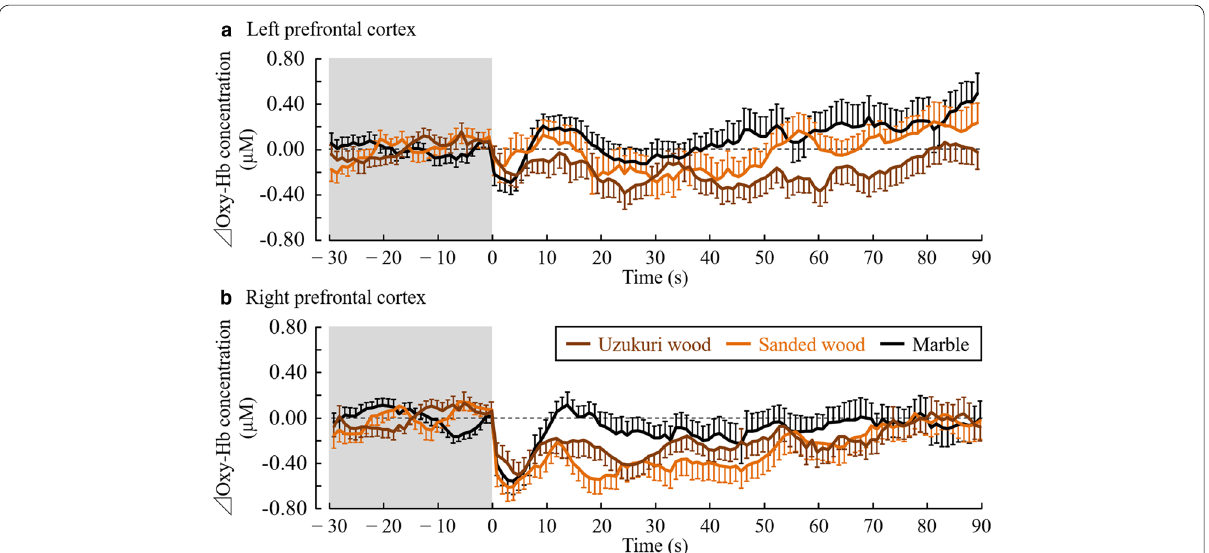
Fig. 4 Changes in the left and right prefrontal cortex activities during sole of the feet contact with the materials for every second over a 90-s period. a Oxy-Hb concentrations in the left prefrontal cortex. b Oxy-Hb concentrations in the right prefrontal cortex. n